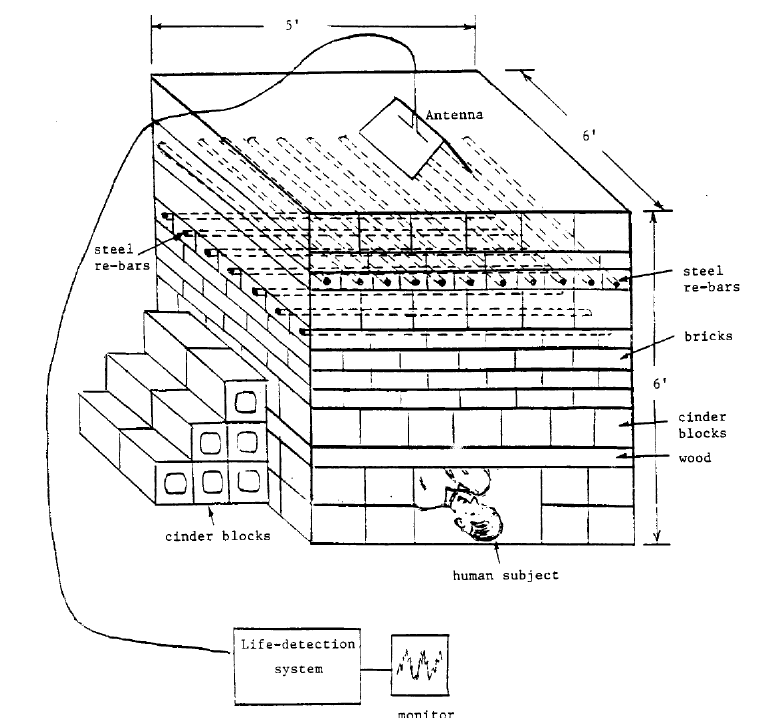
Figure 7. Testing performance of Kum-Mu Chen et al.’s [82] system on the earthquake rubble model of Michigan State